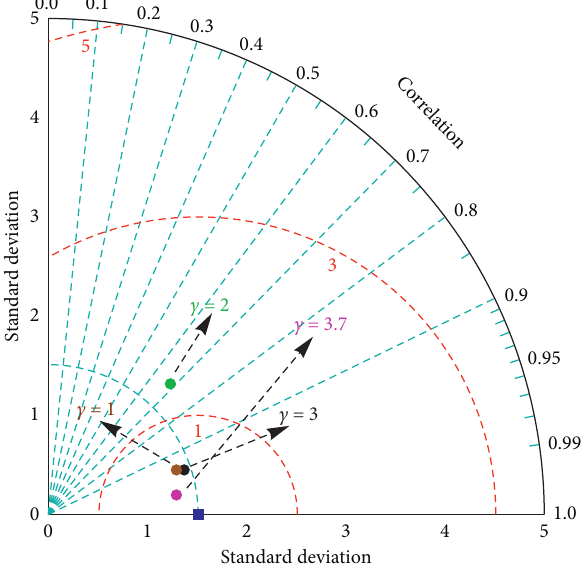
Figure 7: Taylor’s diagram for the model of the lower bounds in Example 1. The rectangle on the x -axis represents the observations, and the red-dashed contours indicate the centered Root Mean Square Errors.